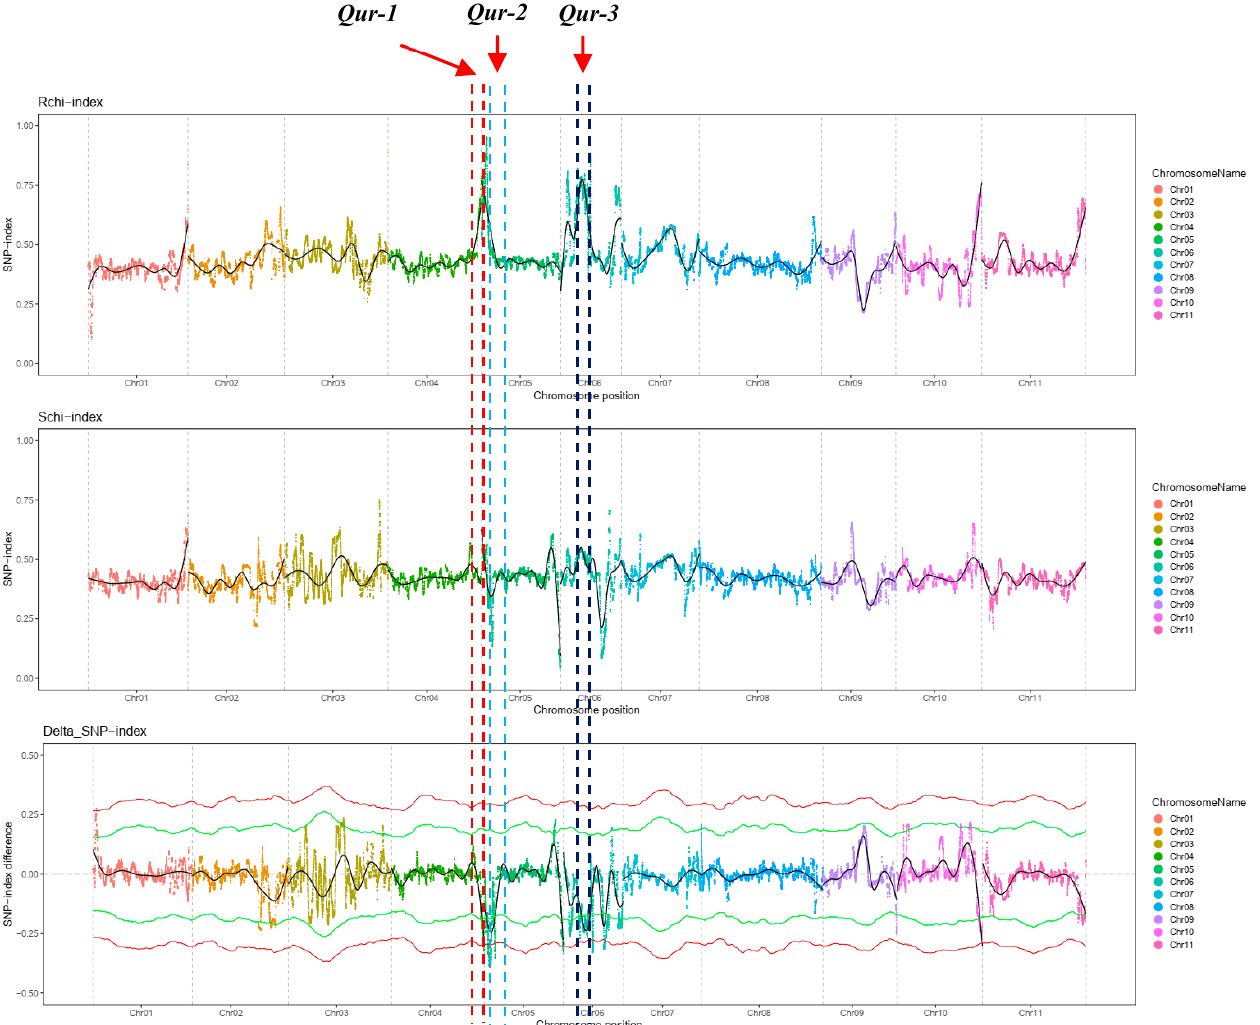
Figure 2. SNP index plot of resistant bulk ( top ) and susceptible bulk ( middle ), ∆ (SNP-index) plot ( bottom ) across the whole genome with statistical confidence interval under the null hypothesis of no QTLs (orange, p < 0.01 and green p < 0.05).